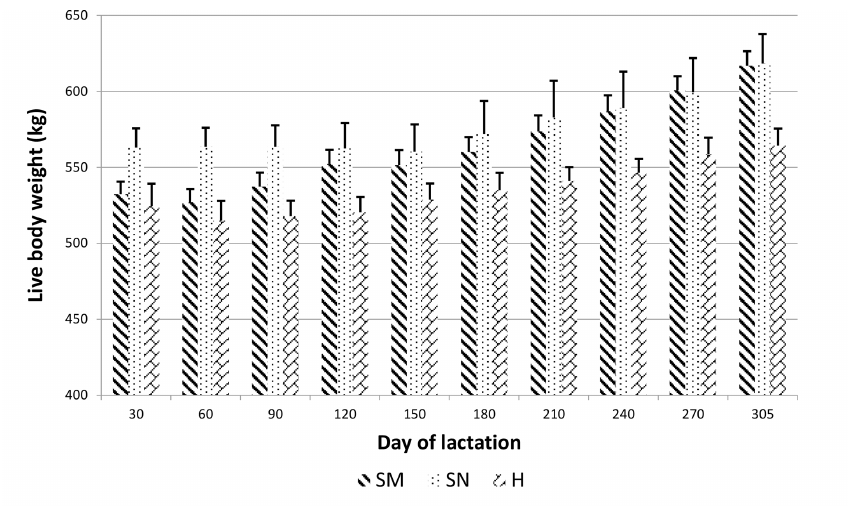
Figure 2. The course of growth of live body weight during lactation.